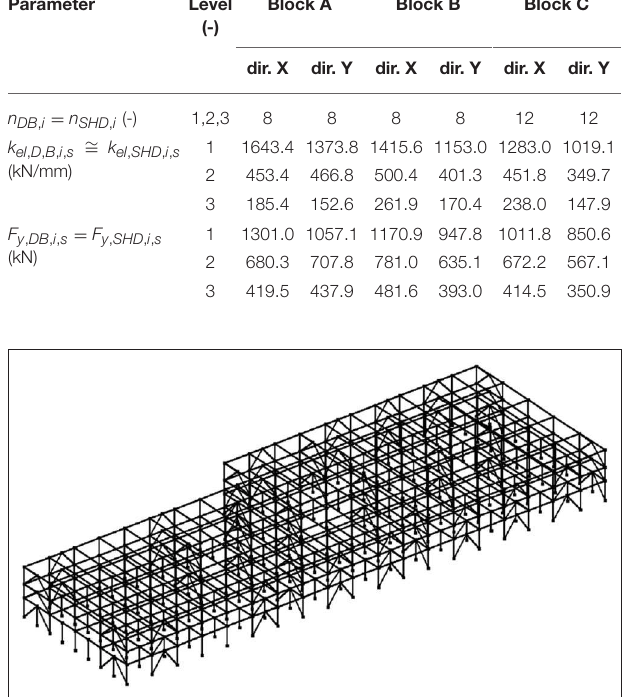
FIGURE 5 | 3D FEM model of the retrofitted “Piastra” building used in nonlinear response history analyses.